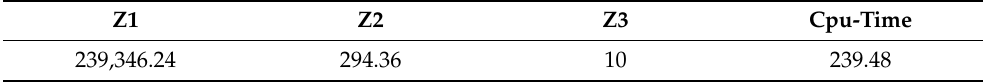
Table 4. The best value of the obtained objective functions assuming an uncertainty rate of 0.5.